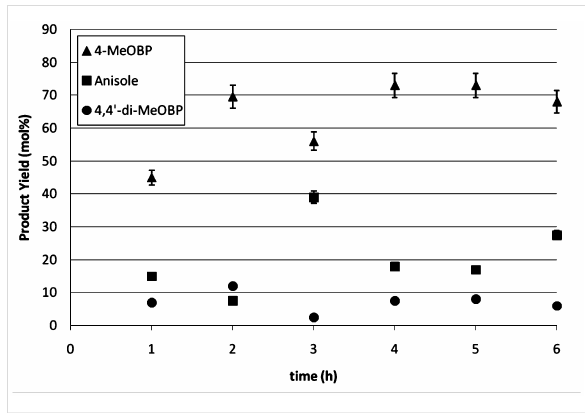
Figure 5: Kumada reaction carried out in a parallel channel meso reactor at a flow rate of 95 ml h −1 .